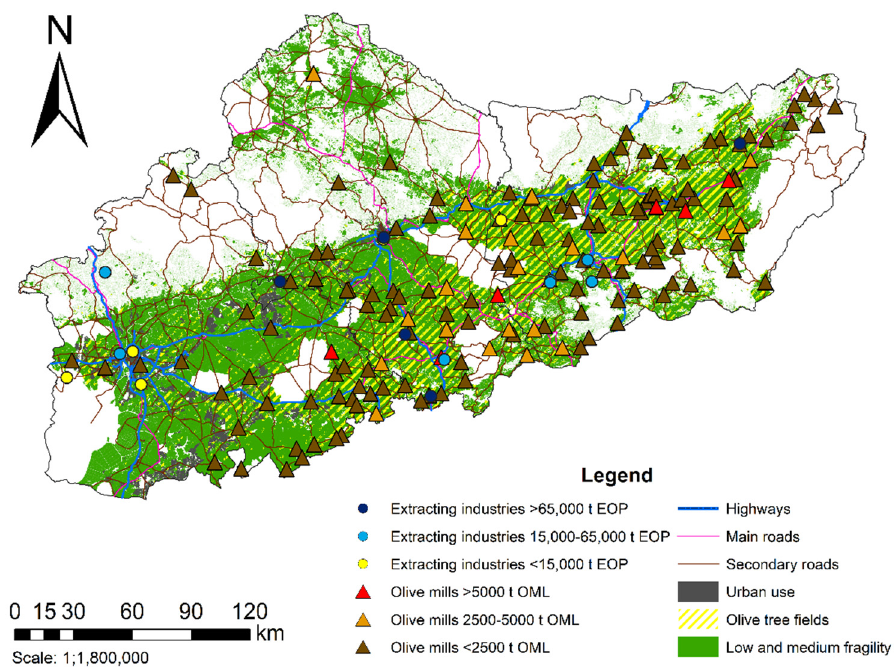
Figure 7. Complete map, including the olive biomass available overlapped with the environmental fragility of the study area.